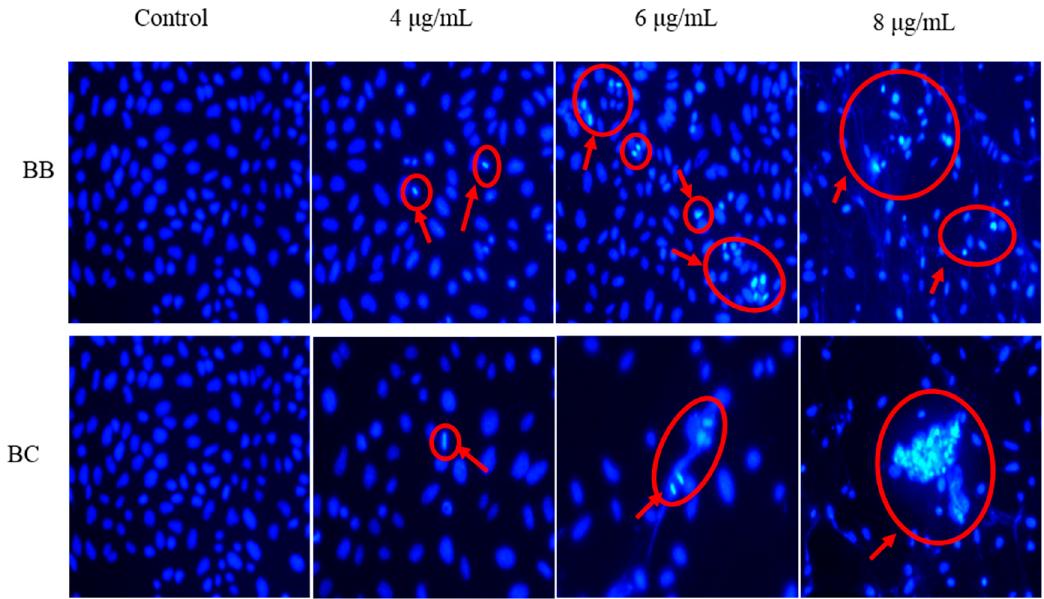
Figure 5. Effects of BB and BC on the nucleus in BGC-823 (enlargement factor: × 100; Circles: Phenomenon characterized by the condensation of the nucleus, leading to the dense staining and fragmentation of a portion of chromatin.).